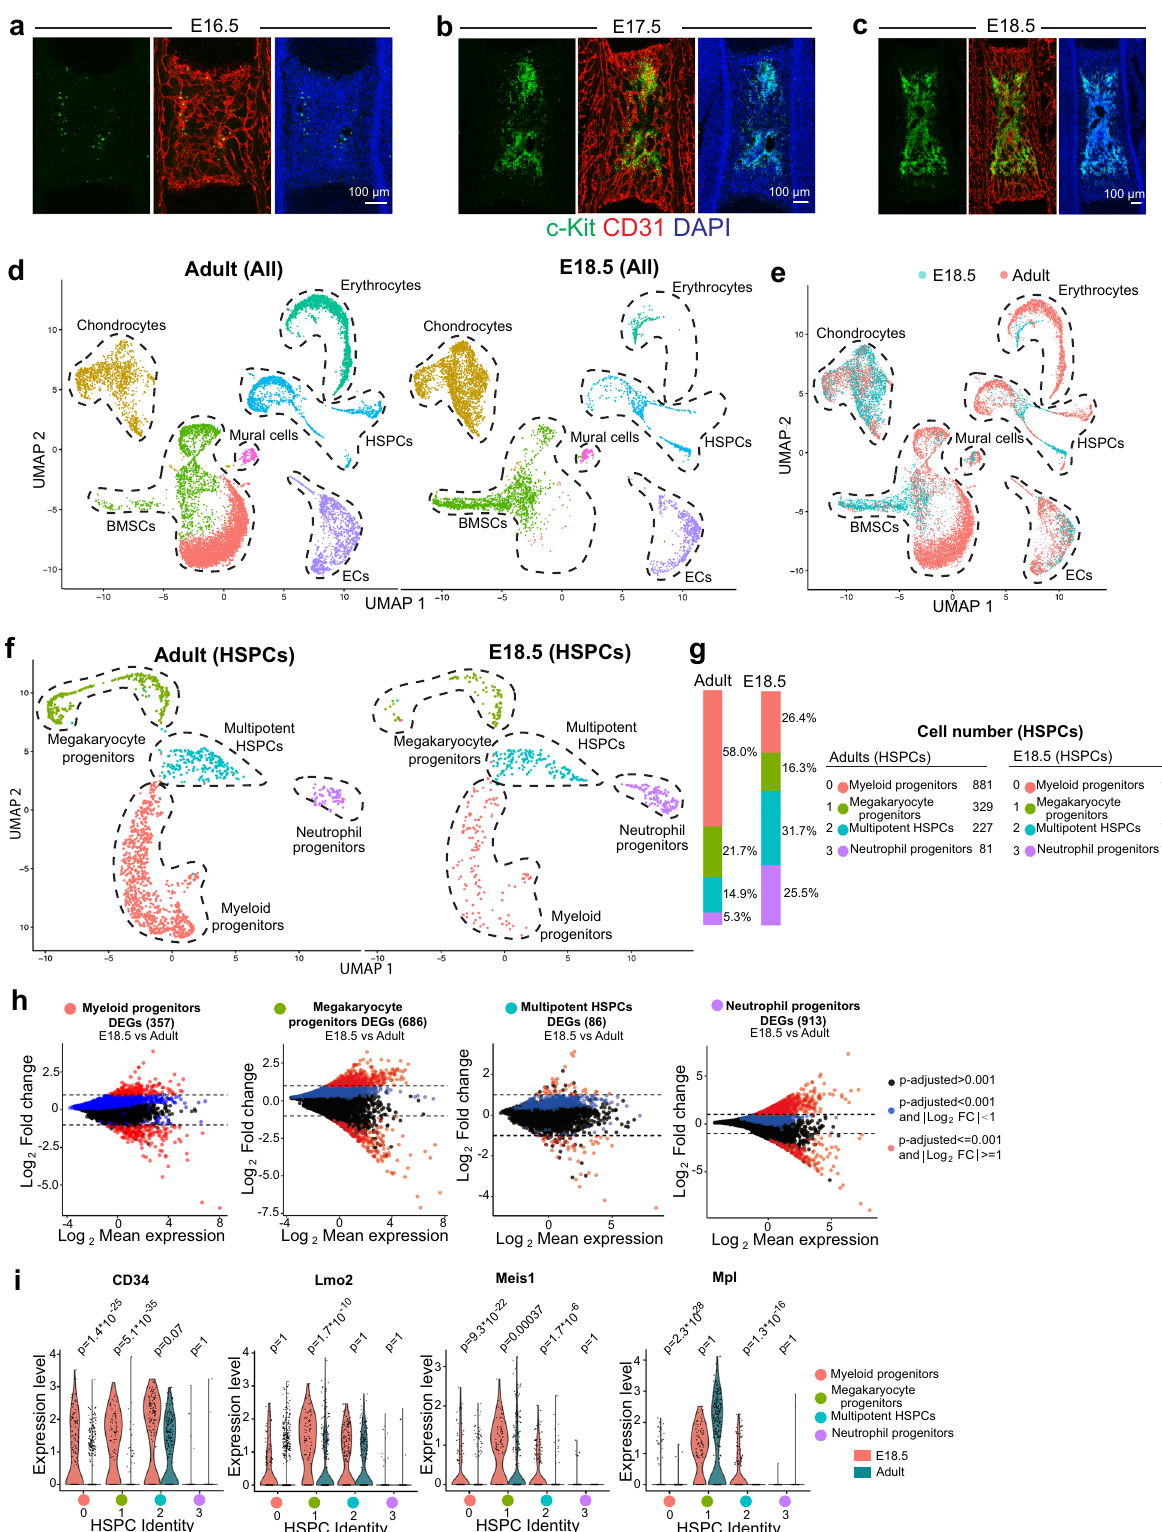
interrelation analysis (Supplementary Fig. 4g), DEG comparison analysis at the subcluster level (Fig. 2f) and interactome analysis of potential interactions with multipotent HSPCs (Supplementary Fig. 4h) support the differences between adult and fetal